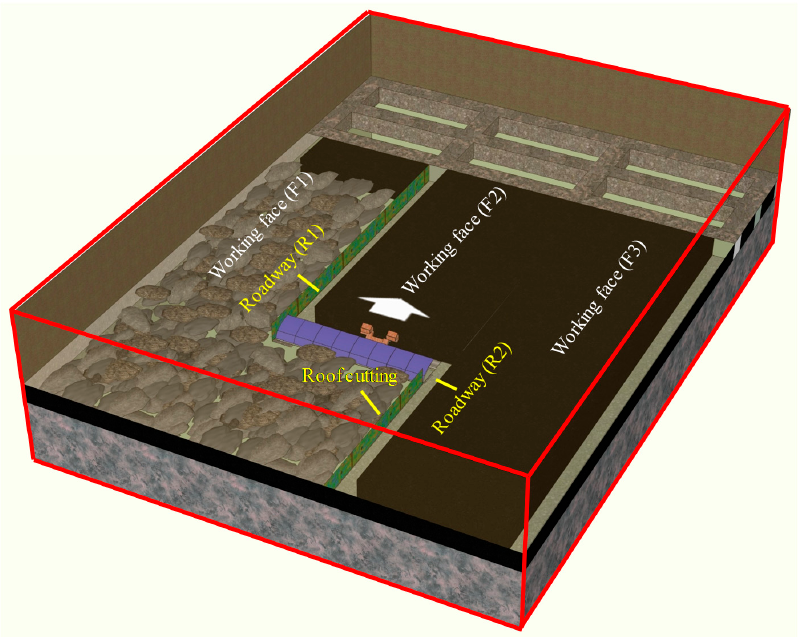
Figure 1. Schematic diagram of the roadway layout.